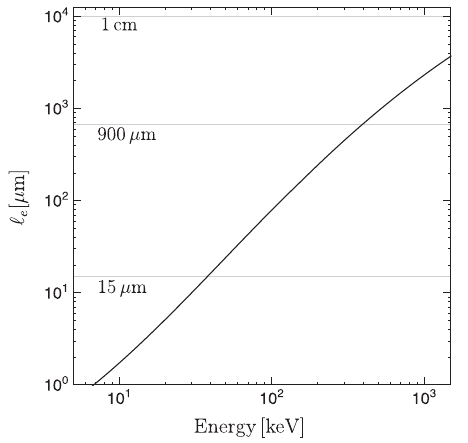
FIG. 7. Percentage of energy lost as Cherenkov radiation by an electronic track with energy E in different materials. The energy e lost as Cherenkov radiation is obtained by calculating the total energy radiated into Cherenkov photons up to the point where the track is stopped due to interactions with the